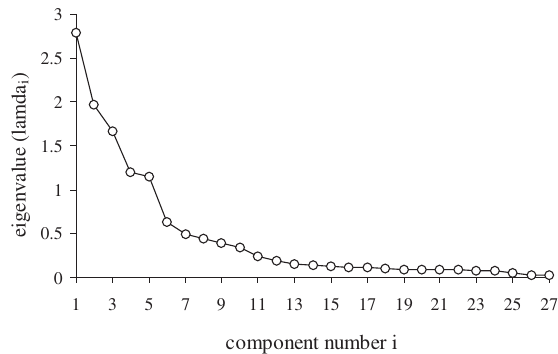
Fig . 6. – Scree diagram for the landings profile data matrix for boat seine fishing trips in the ionian Sea.